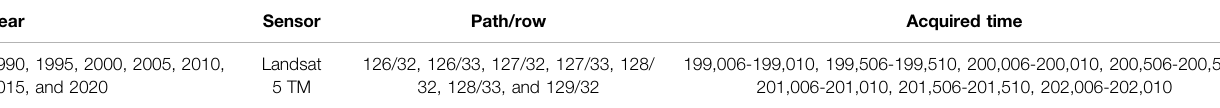
TABLE 1 | Detailed information of the selected images.